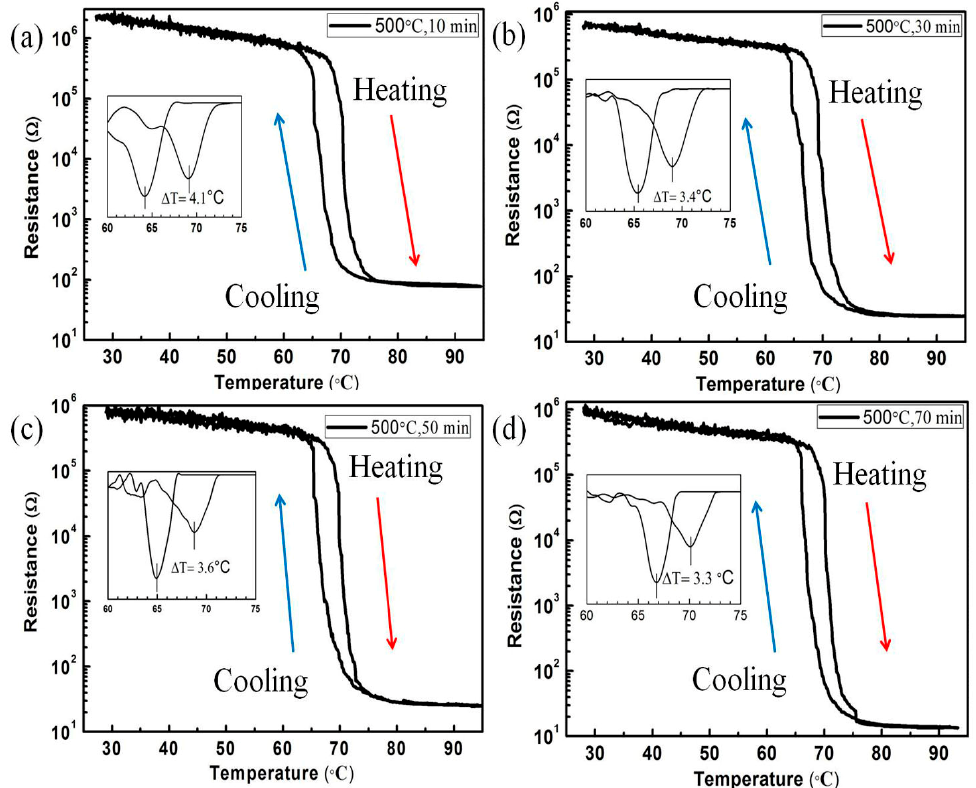
Figure 6. Temperature dependent resistivities of the samples of S 2 group, ( a )–( d ) corresponds to the deposition time of 10 min, 30 min, 50 min and 70 min, respectively. The inset showed the related derivative plot of resistance vs. temperature for VO 2 film on 6H-SiC.